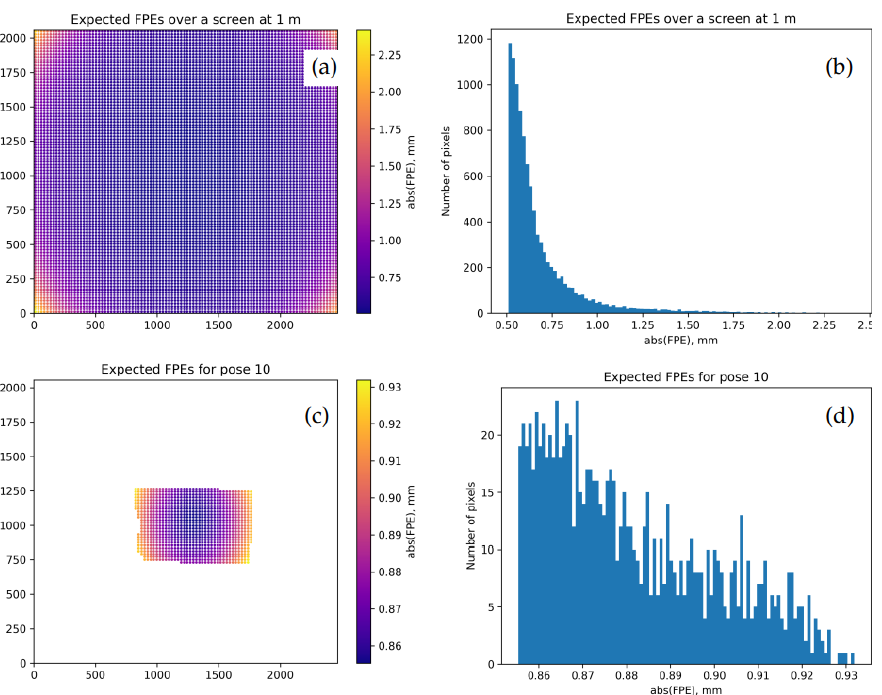
Figure 9. ( a , b ): map and histogram of the final EFPEGs for the model AB calibrated over the dataset 3. ( c , d ): map and histogram of the expected FPEs (EFPEs) for the pose 10. As in Figure 8, the x- and y-axes in ( a , c ) correspond to camera pixel